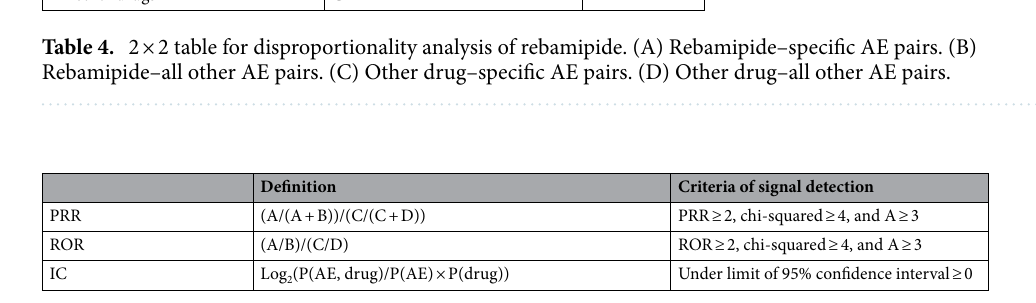
Table 5. Definition and criteria of signal detection for each indicator. IC information component, PRR proportional reporting ratio, ROR reporting odds ratio.